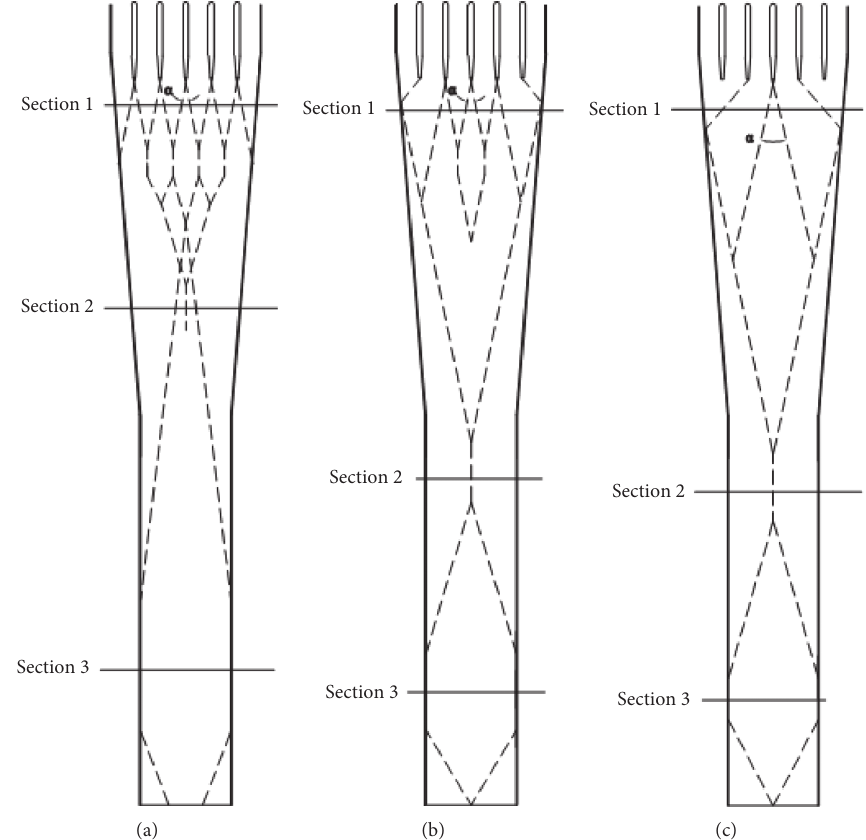
Figure 2: Flow geometric plan under the gates performances. (1) Six gates; (2) four middle gates; (3) two middle